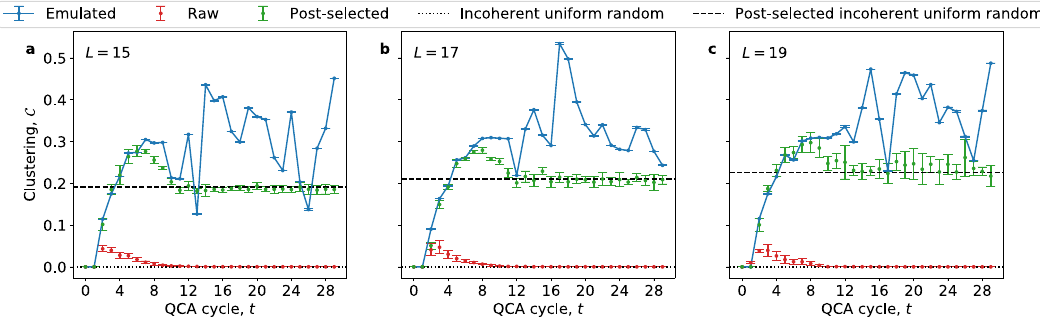
Fig. 3 | QCA mutual information network clustering. Clustering coef fi cient as a function of QCA cycle for three intermediate system sizes simulated on Weber, L =15( a ),17 ( b ),and 19( c ).Blue curves(lines for visualclarity) are calculated from numerical emulation, while red (green) data points are from Weber data without